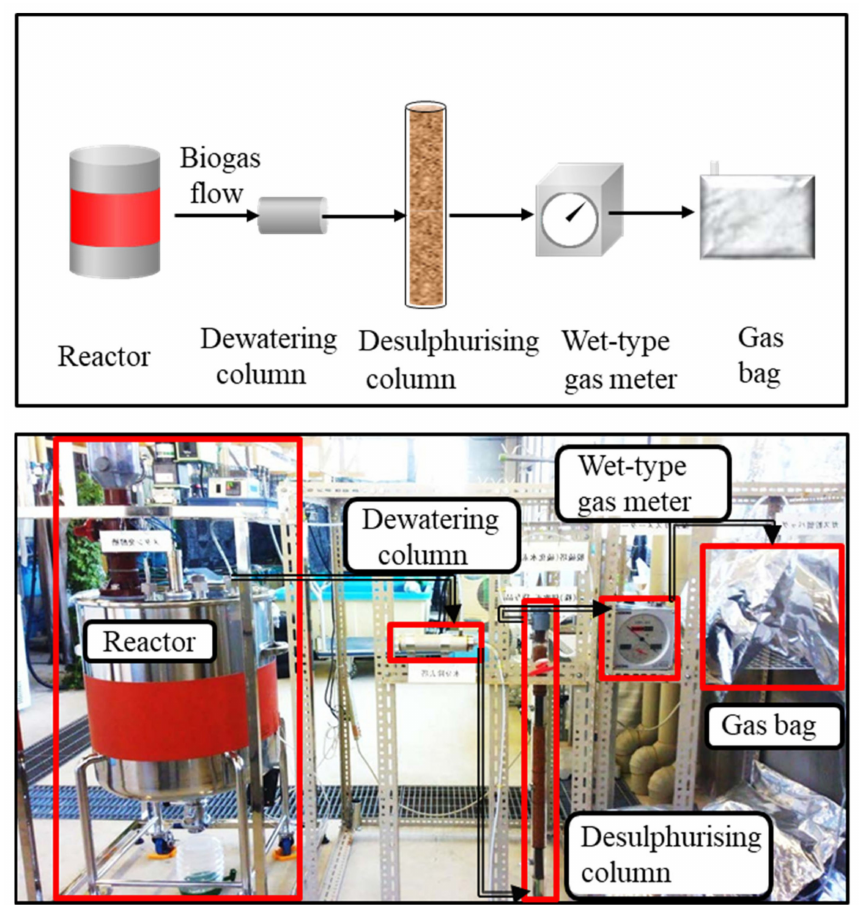
Figure 2. Overview of the continuously stirred tank reactor (CSTR) used in this